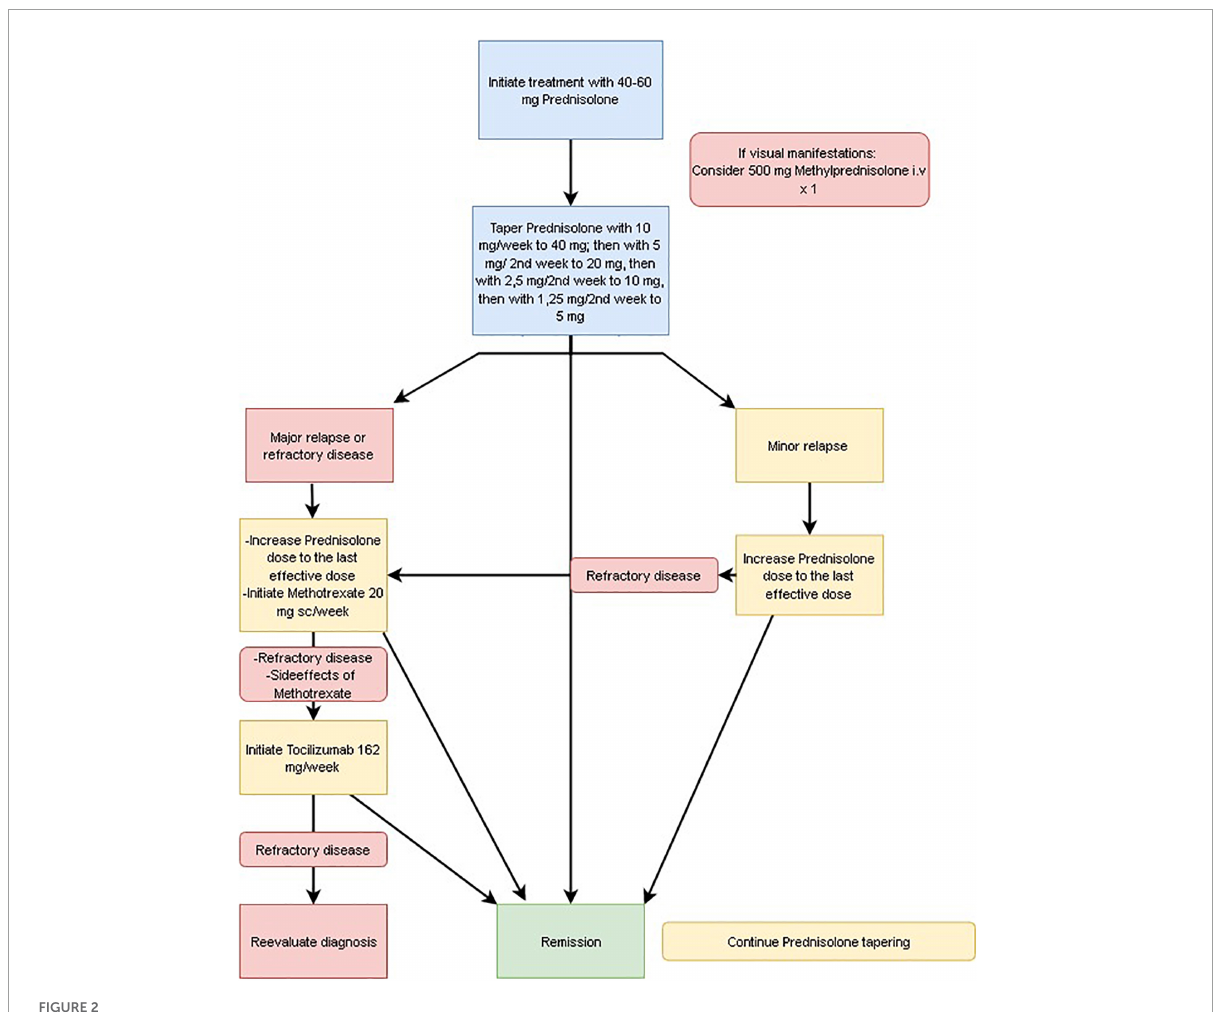
FIGURE2 Treatment algorithm for giant cell arteritis